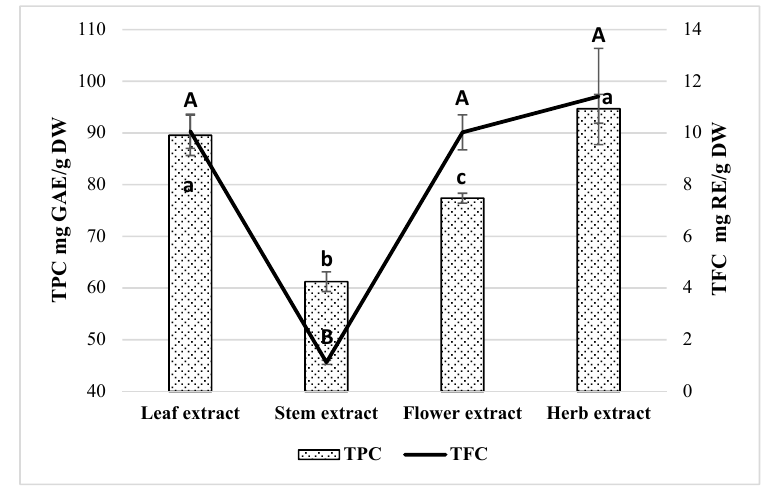
Figure 1. Total phenolic compounds (TPC) and total flavonoid content (TFC) of ethanolic E. ciliata extracts. Results are means ± SD. Values with different capital (TFC) and lowercase (TPC) letter(s) are significantly different ( p < 0.05) measured by Tukey‘s test.